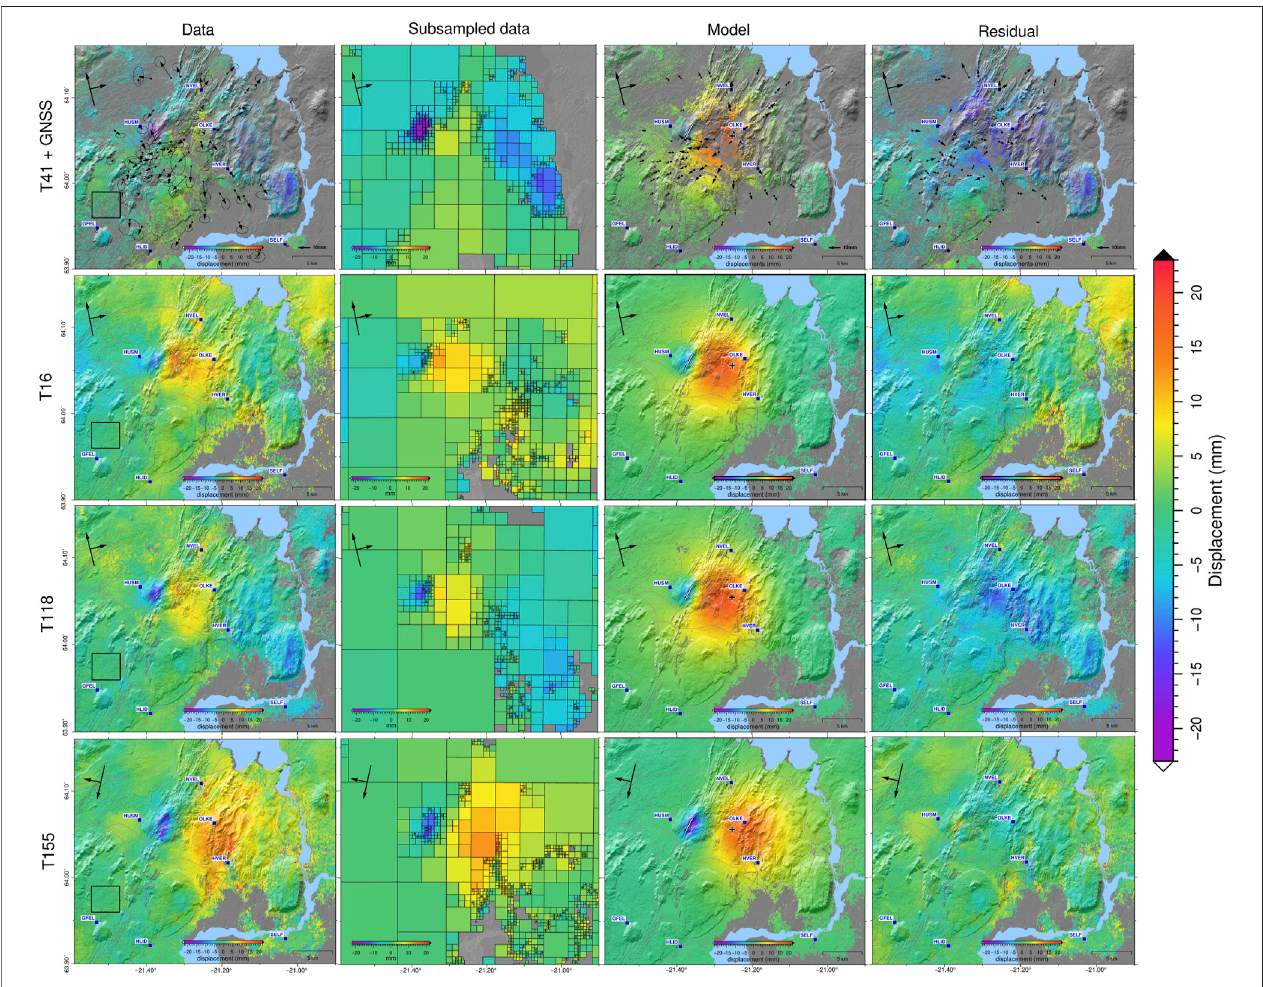
FIGURE 7 | Data, subsampled InSAR data, model-predicted and full residuals displacements of GNSS and InSAR in the LOS of the tracks T41 (TSX), T16 (S1), T118(S1)andT155(S1)accordingtoourfavouredmodel( Table2 ).Thecrosspresentsthelocationofbest fi tpointsource(followingtheexpressionsofLisowski,2007) for Ölkelduháls (black) and the elongated ellipse for the prolate spheroid source (Battaglia et al., 2013) for Húsmúli (white) sources.